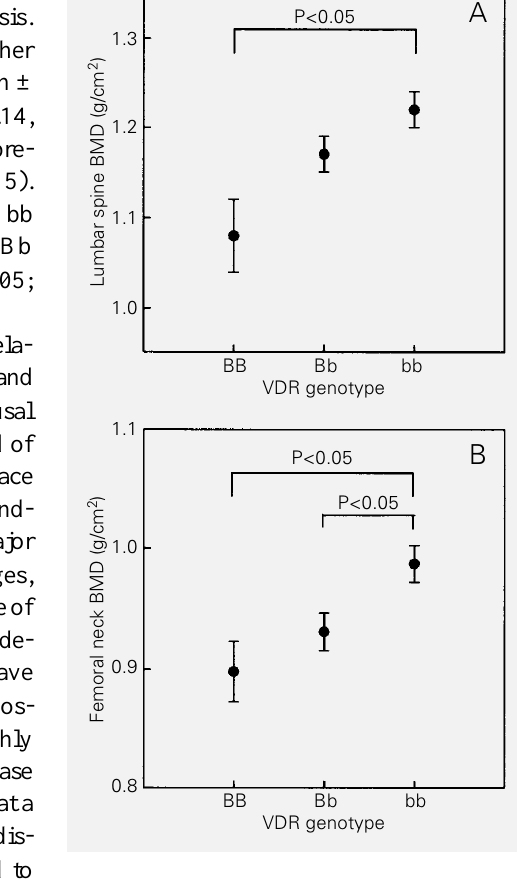
Figure 1 - Allele effect of the vitamin D receptor (VDR) geno- type on lumbar spine (A) and femoral neck (B) bone mineral density (BMD) in premeno- pausal Brazilian women. Data are reported as mean – SEM for 127 women (13 BB, 62 Bb and 52 bb). Unpaired t -test was used for statistical